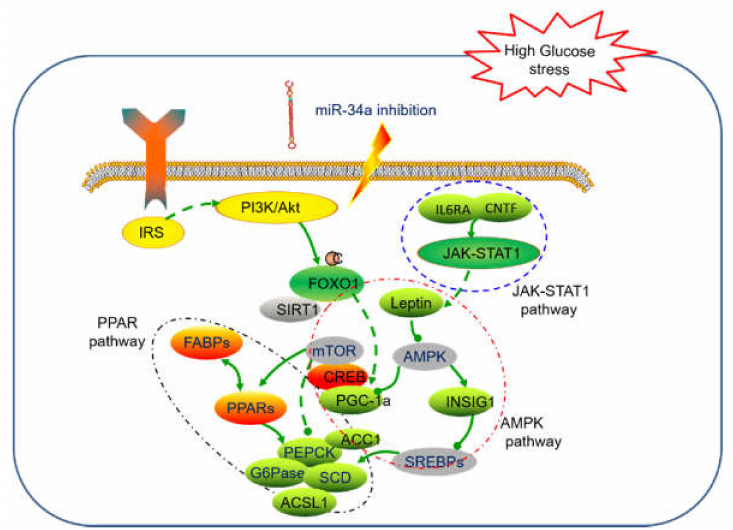
Figure 9. The potential interaction and molecular mechanism of putative genes involved in glucose metabolism process regulated by miR-34a inhibition. Green indicates downregulation, while and red and yellow note upregulation in our study. Gray notes no detection of dysregulation. The blue, red and grey circles include related genes in JAK-STAT1 pathway, AMPK pathway and PPAR pathway, respectively. The green line with an arrow and the green line with a ball stand for positive and negative effect between genes, and the green dot line with an arrow and the green dot line with a ball stand for supposed positive and negative effect between